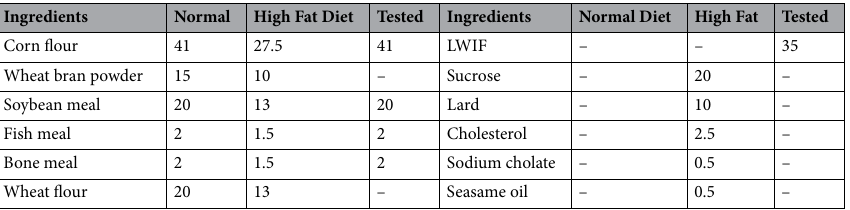
Table 1. Composition of experimental diets (g/100 g